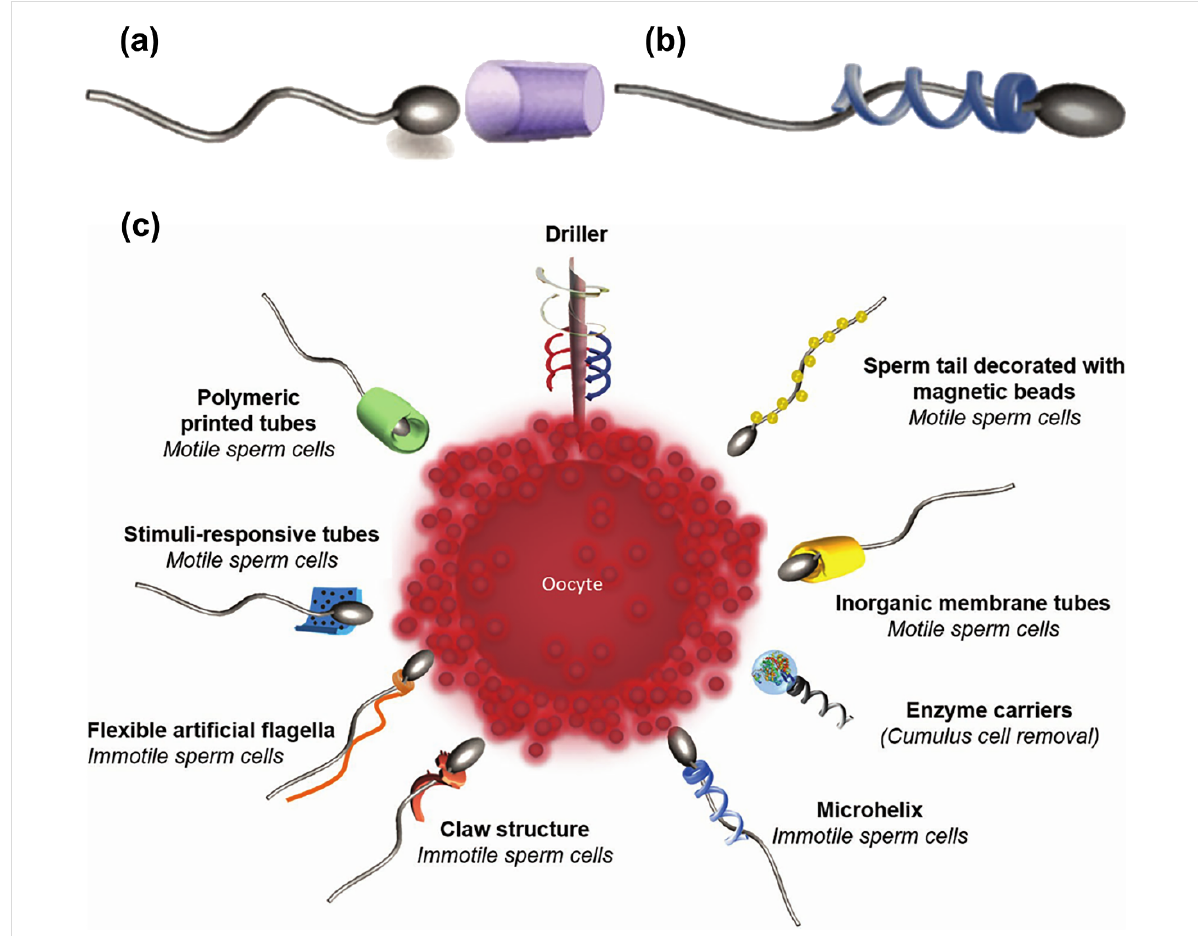
Figure 3: (a) Tubular, (b) helical, and (c) novel microswimmer designs for fertilization. Clockwise from top: magnetically actuated drillers for pene- trating the cumulus layer of the oocyte; sperm tail decorated with magnetic beads for magnetic actuation of the tail; rolled-up microtubes made of inor- ganic nanomembranes for the guidance of motile sperm cells; magnetic helical enzyme carriers for the cumulus cell removal by enzymes (e.g., hyaluronidase); artificial flagella with multiple windings and a claw-shaped sperm carrier for the delivery of immotile sperm cells; artificial flexible flagella for transport of immotile spermatozoa; stimuli-responsive polymeric microtubes for the delivery of motile spermatozoa; and polymeric printed microtubes for the guidance of motile sperm cells. Panels (a–c) adapted from [85], V. Magdanz et al., “Spermatozoa as Functional Components of Robotic Microswimmers”, Adv. Mater., with permission from John Wiley and Sons. Copyright © 2017 WILEY-VCH Verlag GmbH & Co. KGaA, Wein- heim. This content is not subject to CC BY